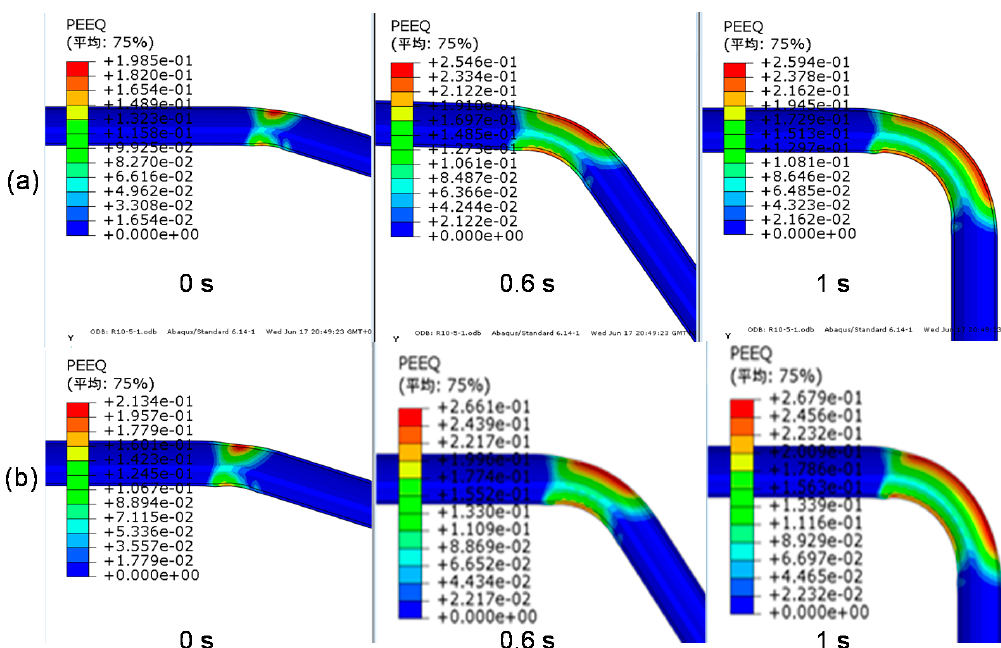
Figure 5. Variation of equivalent strain distribution with time in ( a ) non-EA and ( b ) EA RDB process of micro-tube with 5 mm diameter and 10 mm bending radius.